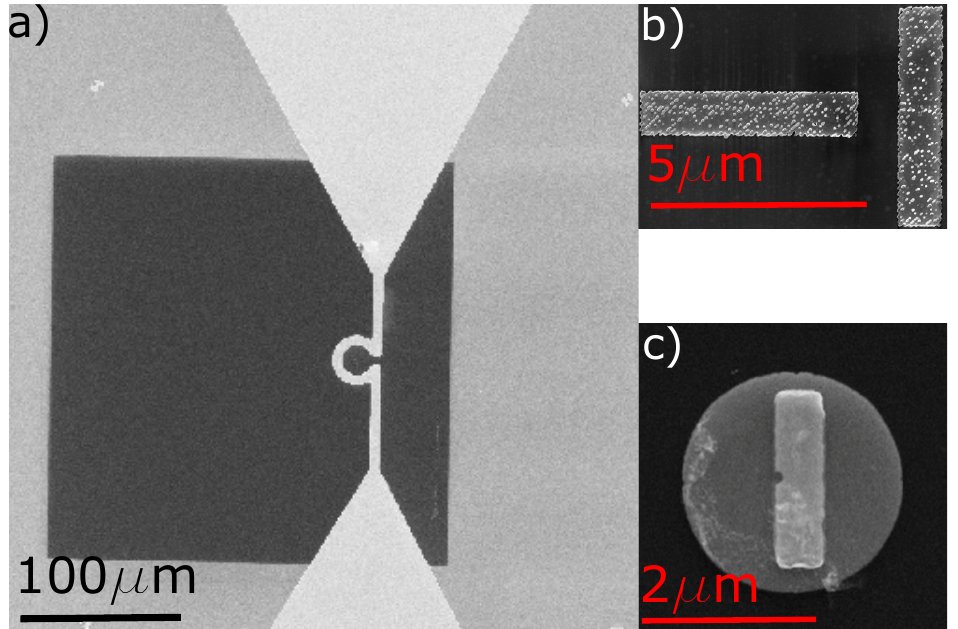
Figure 1. ( a ) Scanning electron microscope (SEM) image of the strip-line resonator on top of a SiN-membrane. For this work, two different sample systems were chosen. In ( b ), two